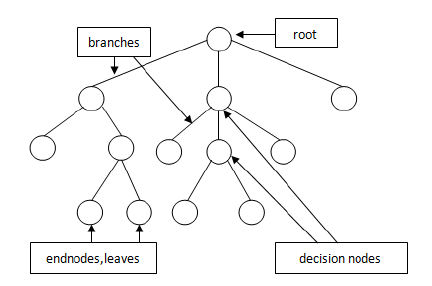
Figure 3. The structure of decision